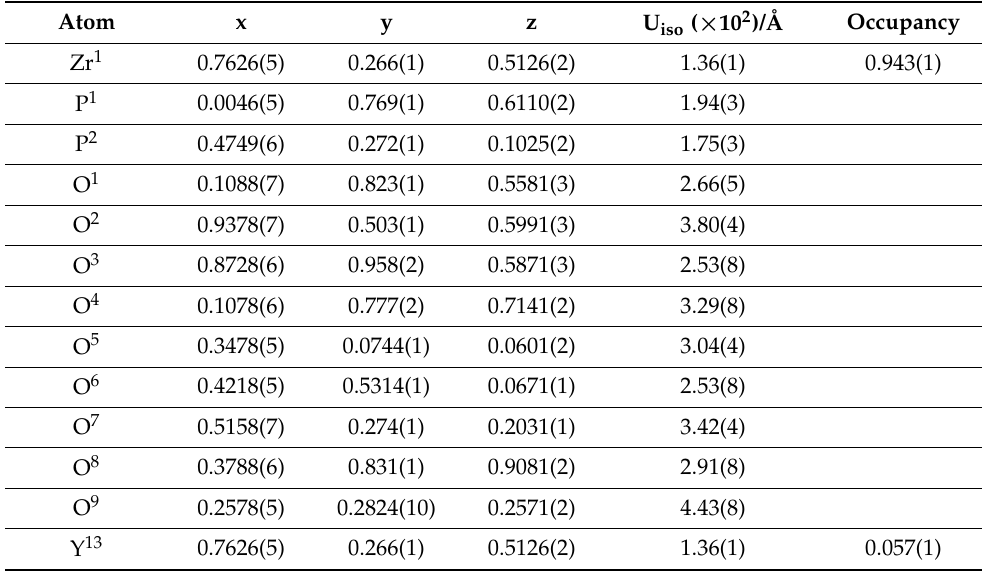
Table 7. Refined fractional atomic coordinates and isotropic thermal displacement parameters for hydrothermally synthesised 5% Y–ZrP.